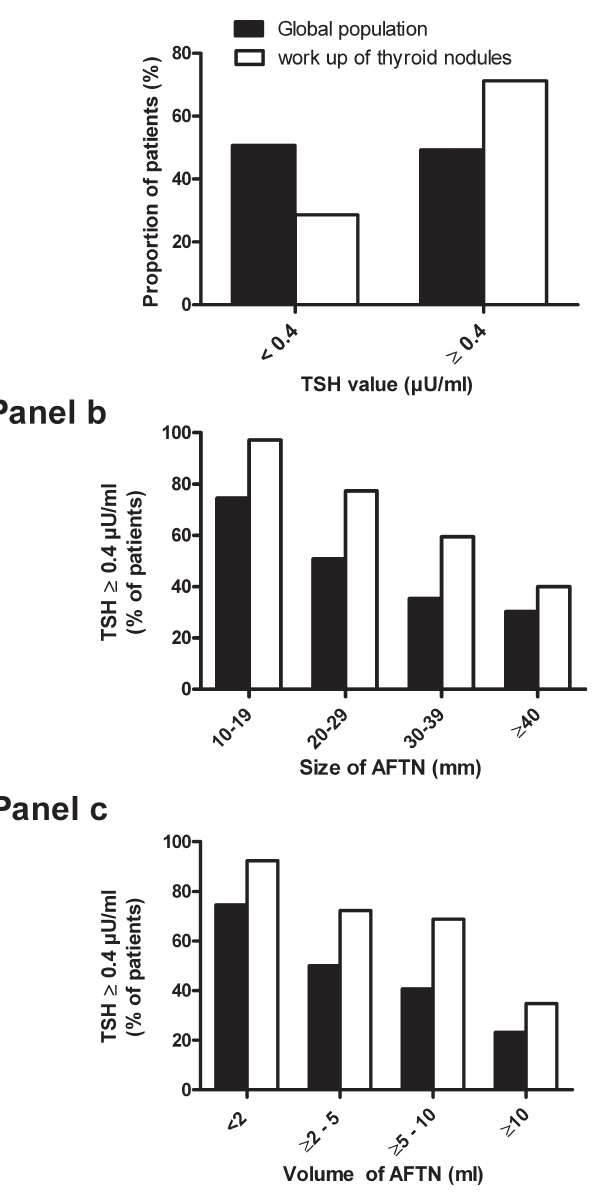
Figure 1. TSH level in patients with an autonomously functioning thyroid nodule. Panel a : Proportion of patients with an autonomously functioning thyroid nodule (AFTN) and a normal thyroid-stimulating hormone (TSH) level (Black bars: global population; white bars: subpopulation in which the AFTN was discovered in the workup of a thyroid nodule). Panels b and c : Proportion of patients with a normal TSH level according to the size of the nodule; main diameter ( panel b ) or volume ( panel c ). (Black bars: global population; white bars: subpopulation in which the AFTN was discovered in the workup of a thyroid